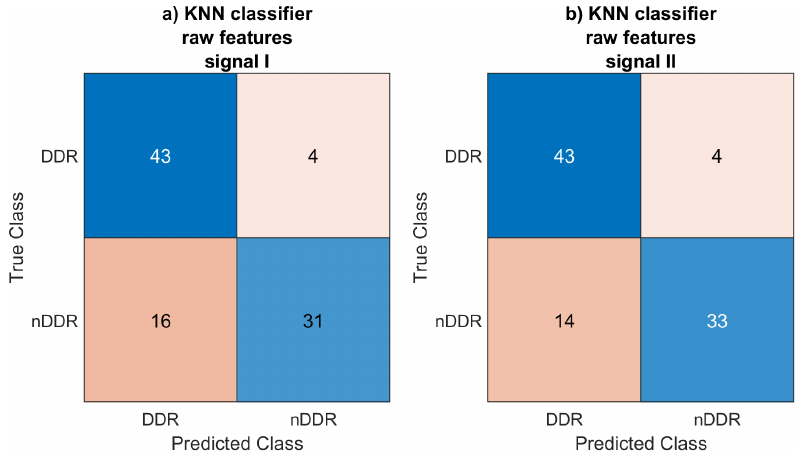
Figure A10. Confusion matrices for raw features used in the KNN classifier for the ( a ) first and ( b ) second